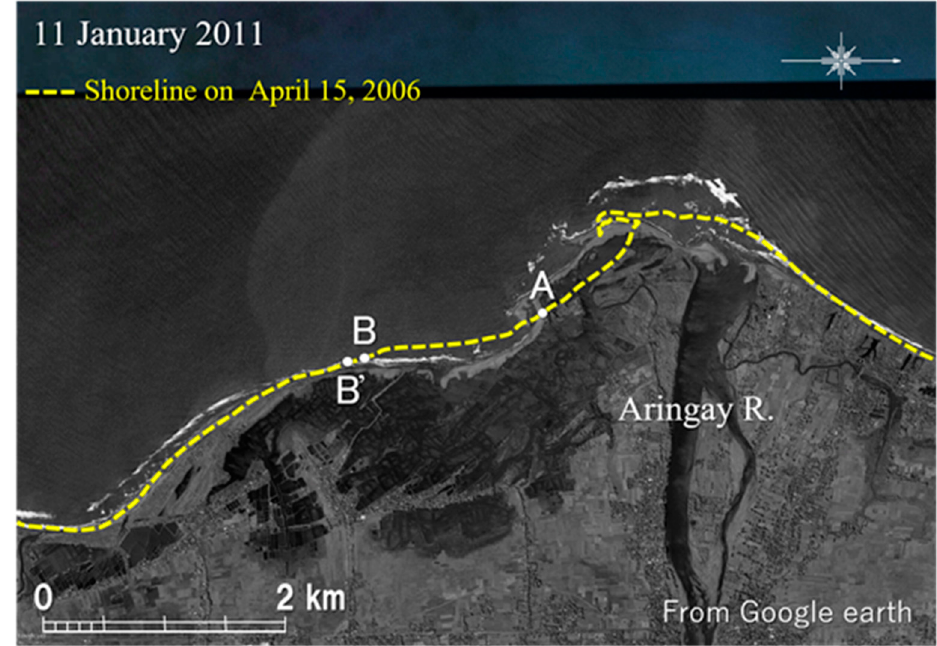
Figure 13. Satellite image of shoreline around Aringay River mouth (11 January 2011).